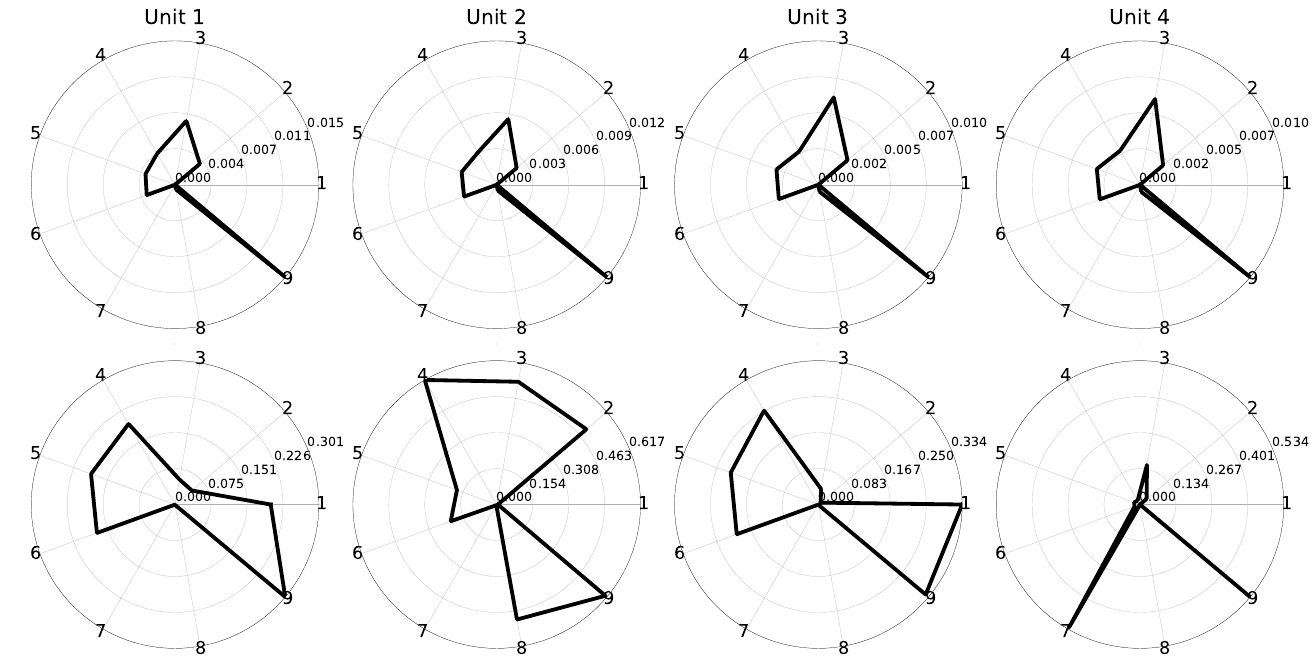
Figure 15. FCAE loss signatures per cooling unit for the true negative cases ( top ) and the false positives ( bottom ). However, we noticed that loss signatures are model dependent. For instance, we can see in Figure 16 how the false negatives and false positive loss signatures for a LSTMAE (run lstmae_pca_10 ) can be significantly different from the FCAE ones.